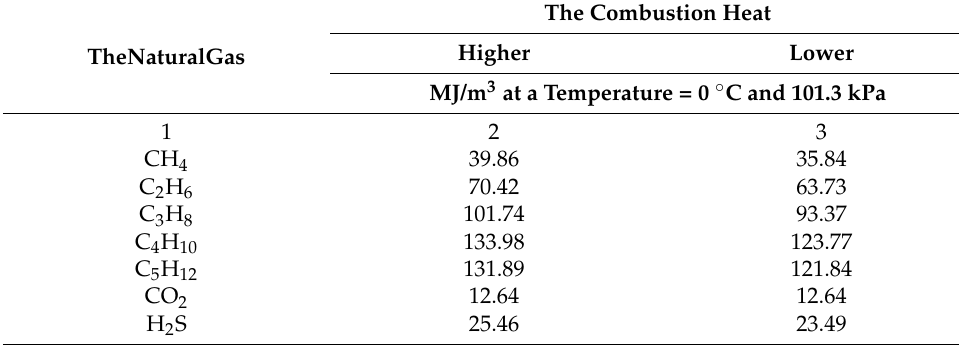
The Combustion Heat Higher